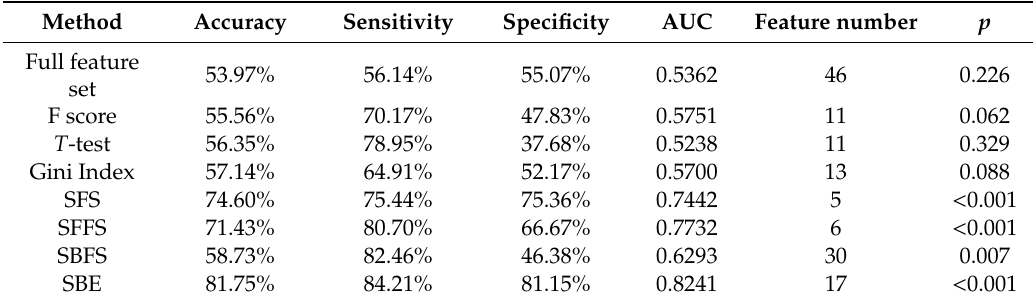
Table 2. Evaluation metrics of seven feature selection approaches and the full feature set with a linear support vector machine (SVM) classifier.